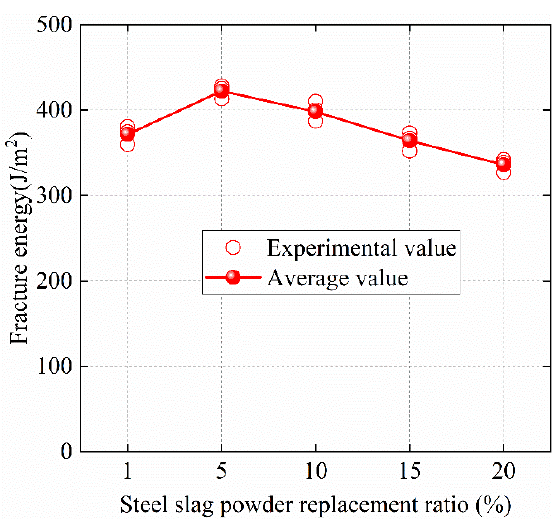
Figure 5. Load-deflection (P- δ) curves .